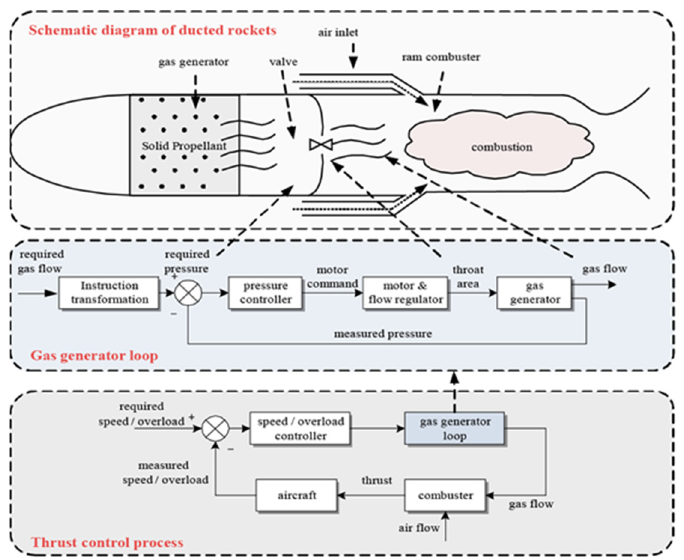
Figure 1. Schematic diagram of VFDR and gas flow control process.